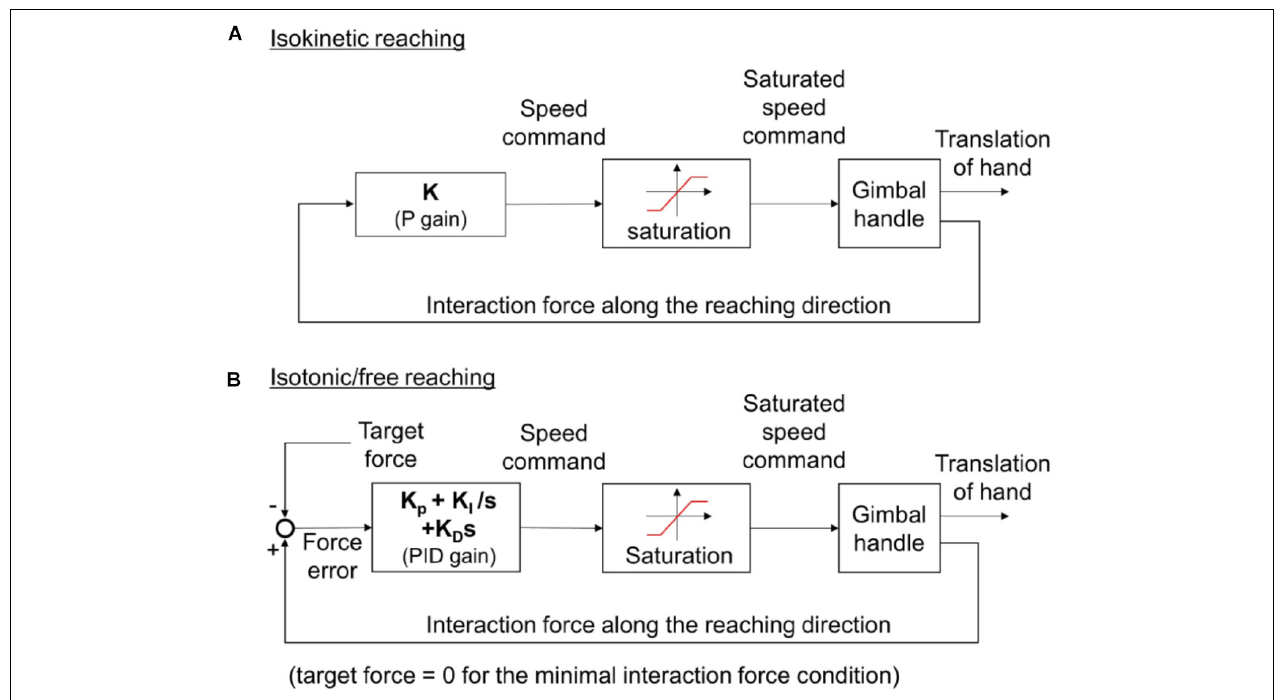
FIGURE 2 | (A) The control algorithm for isokinetic reaching. (B) The control algorithm for isotonic and free reaching. The target force is set to be zero in case of free reaching. For the isokinetic reaching, the speed command is proportional (i.e., multiplied by a constant gain, K ) to the magnitude of the interaction force that a subject applies to the handle. For the isotonic or free reaching, the speed command is determined by the PID control law from the force error, the difference between the force that a subject applies to the handle and target force. K P , K I , and K D represent the proportional, integral, and differential gains, respectively.